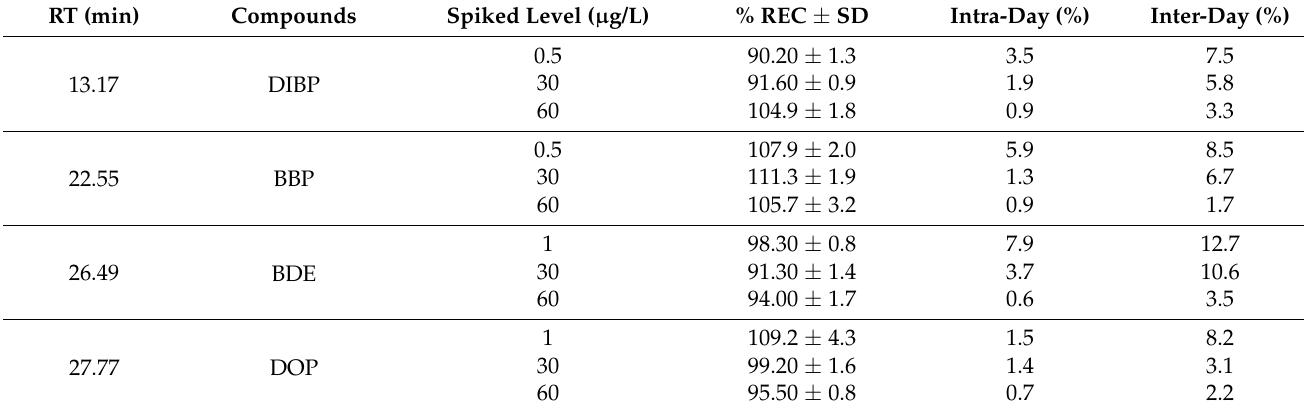
Table 2. Recovery and precision of phthalates in food packaging, using sample 3, at three spiked levels *. RT (min)